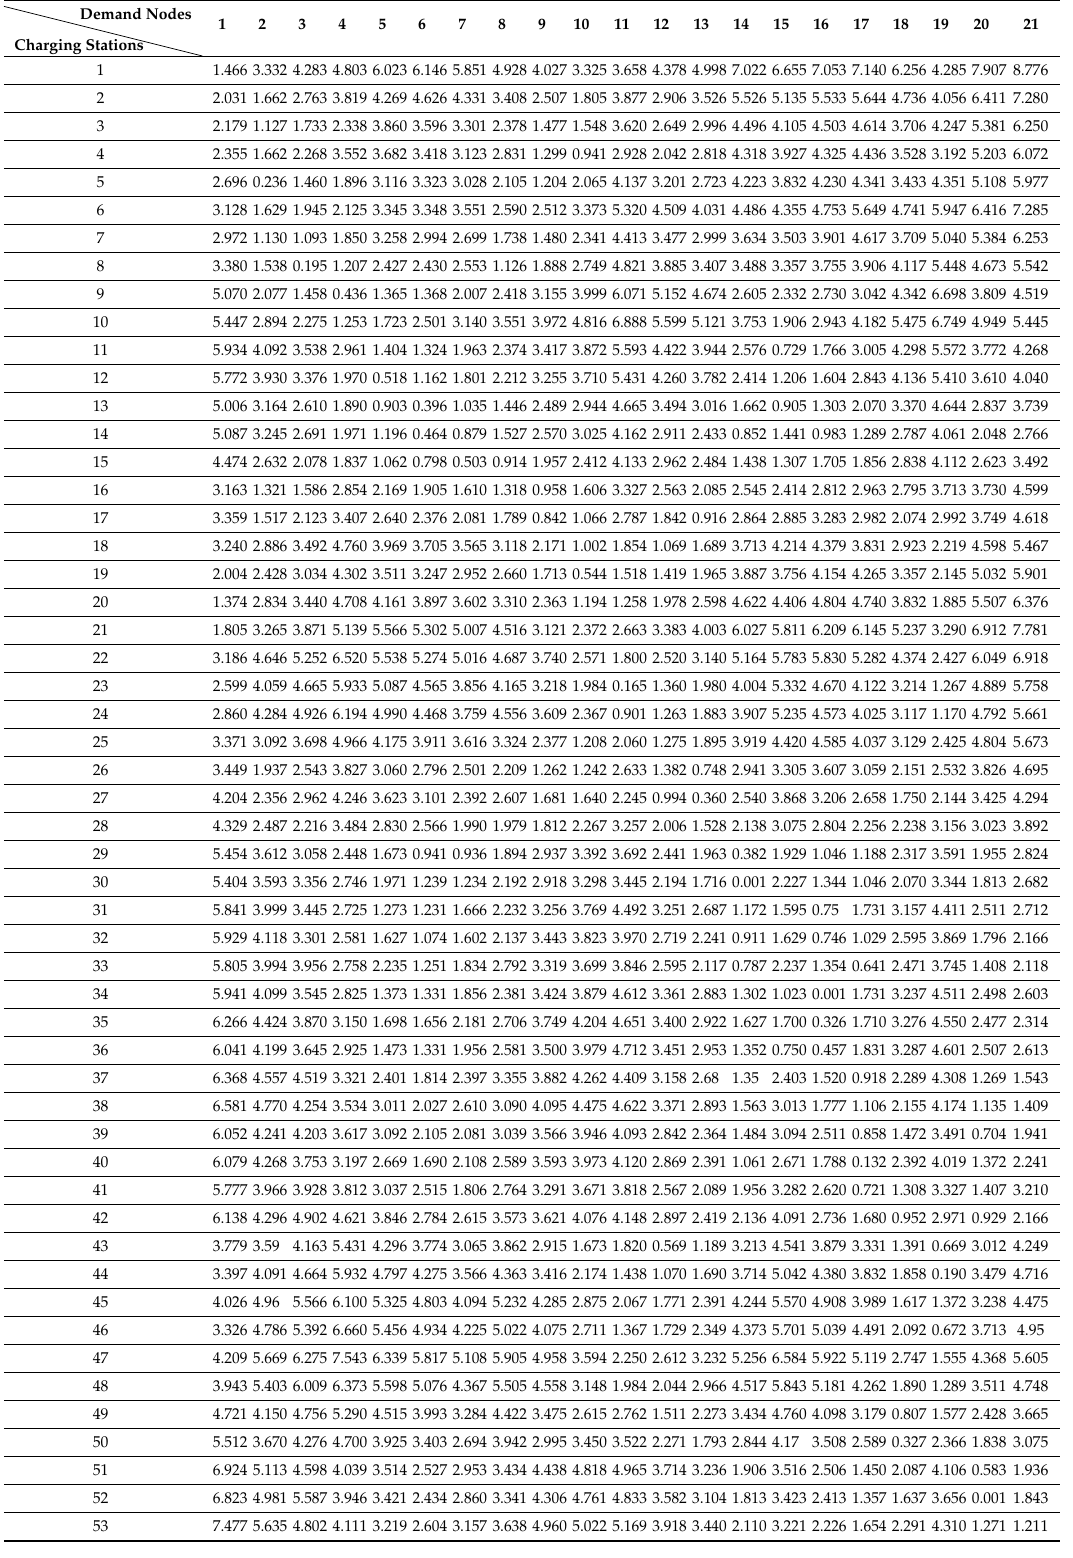
Table A1. The distance between demand nodes and alternative charging stations (km). StationsDemand Charging